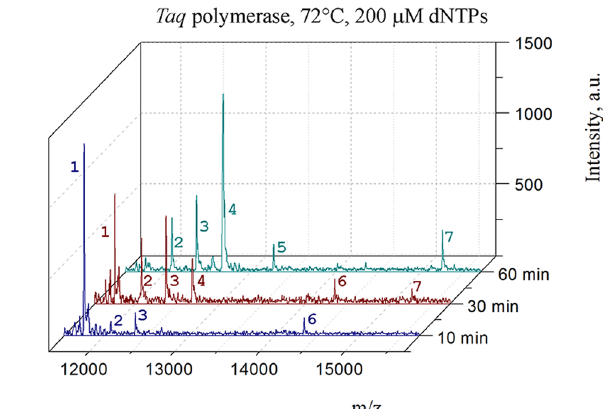
Figure 3. MS analysis of the PE reaction mixtures with Taq polymerase at 72 °C. PE was performed with a mixture of dATP, dGTP, dCTP, and Y for varying amounts of time (10, 30, and 60 min). The concentration of the nucleotides was 200 μ M (each). The peaks were assigned based on their m/z values as follows: (1) M; (2) M + dA; (3) M-dT + Y; (4) M + Y, M-dT + Y + dA and M-dT + Y + dG; (5) M-dT + Y + Y; (6) F; and (7) F + Y. Taq polymerase generates a diverse pool of products because of the enzyme transferase activity and nucleotide exchange via